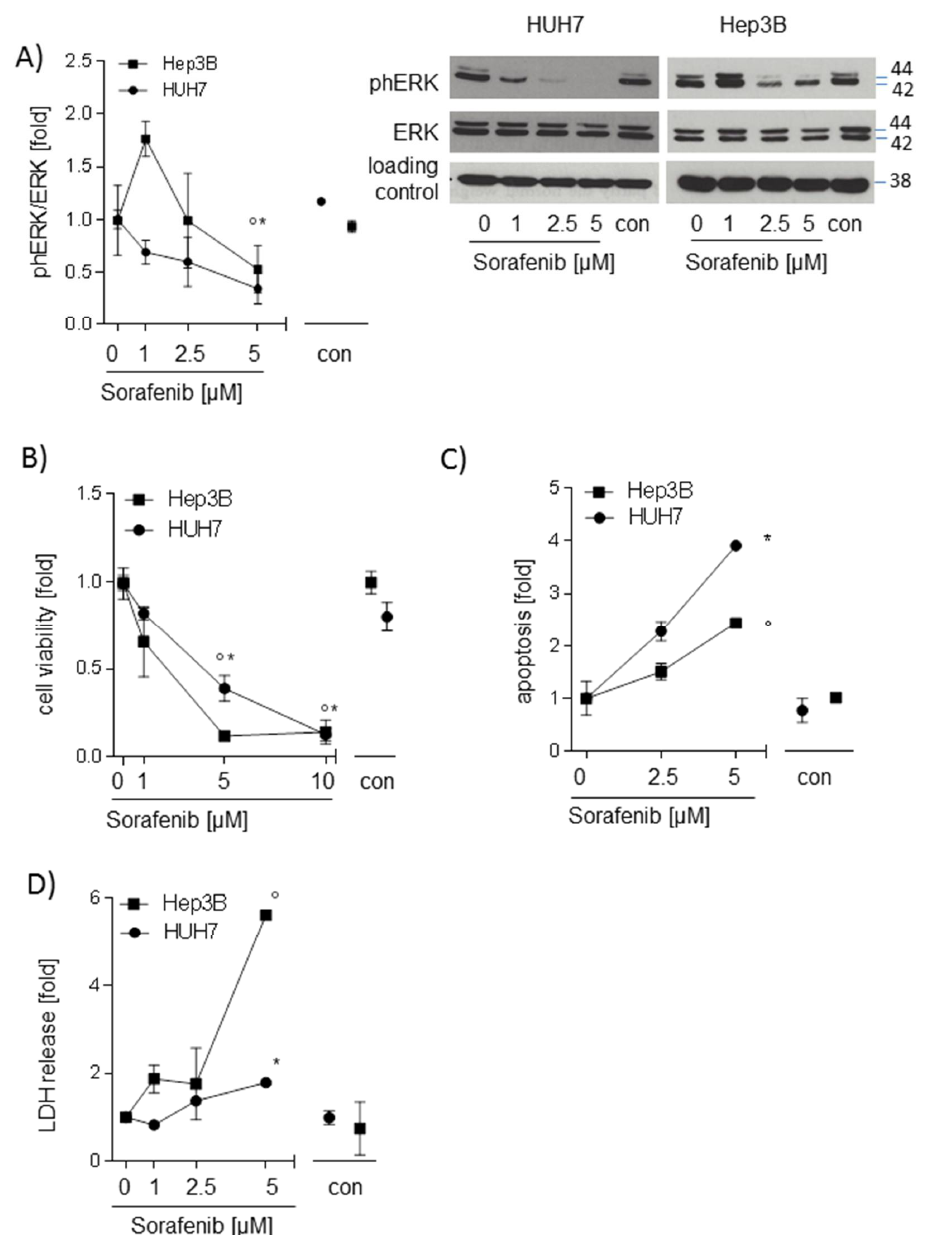
Figure 1. Sorafenib decreases phosphorylation of extracellular signal regulated kinase (ERK) and induces apoptosis in hepatocarcinoma cell lines (HUH7, Hep3B) ( A ) Western blot analysis of ph-ERK and total ERK after stimulation with sorafenib (1 µM; 2.5 µM, and 5 µM) for 24h. One representative blot out of three experiments is shown. Densitometric analysis was performed to semi-quantify